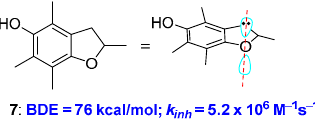
Figure 4. E ff ect of ring size on BDE of benzo-fused oxygen Figure 4. Effect of ring size on BDE of benzo-fused oxygen heterocycles. Figure 4. Effect of ring size on BDE of benzo-fused oxygen heterocycles.